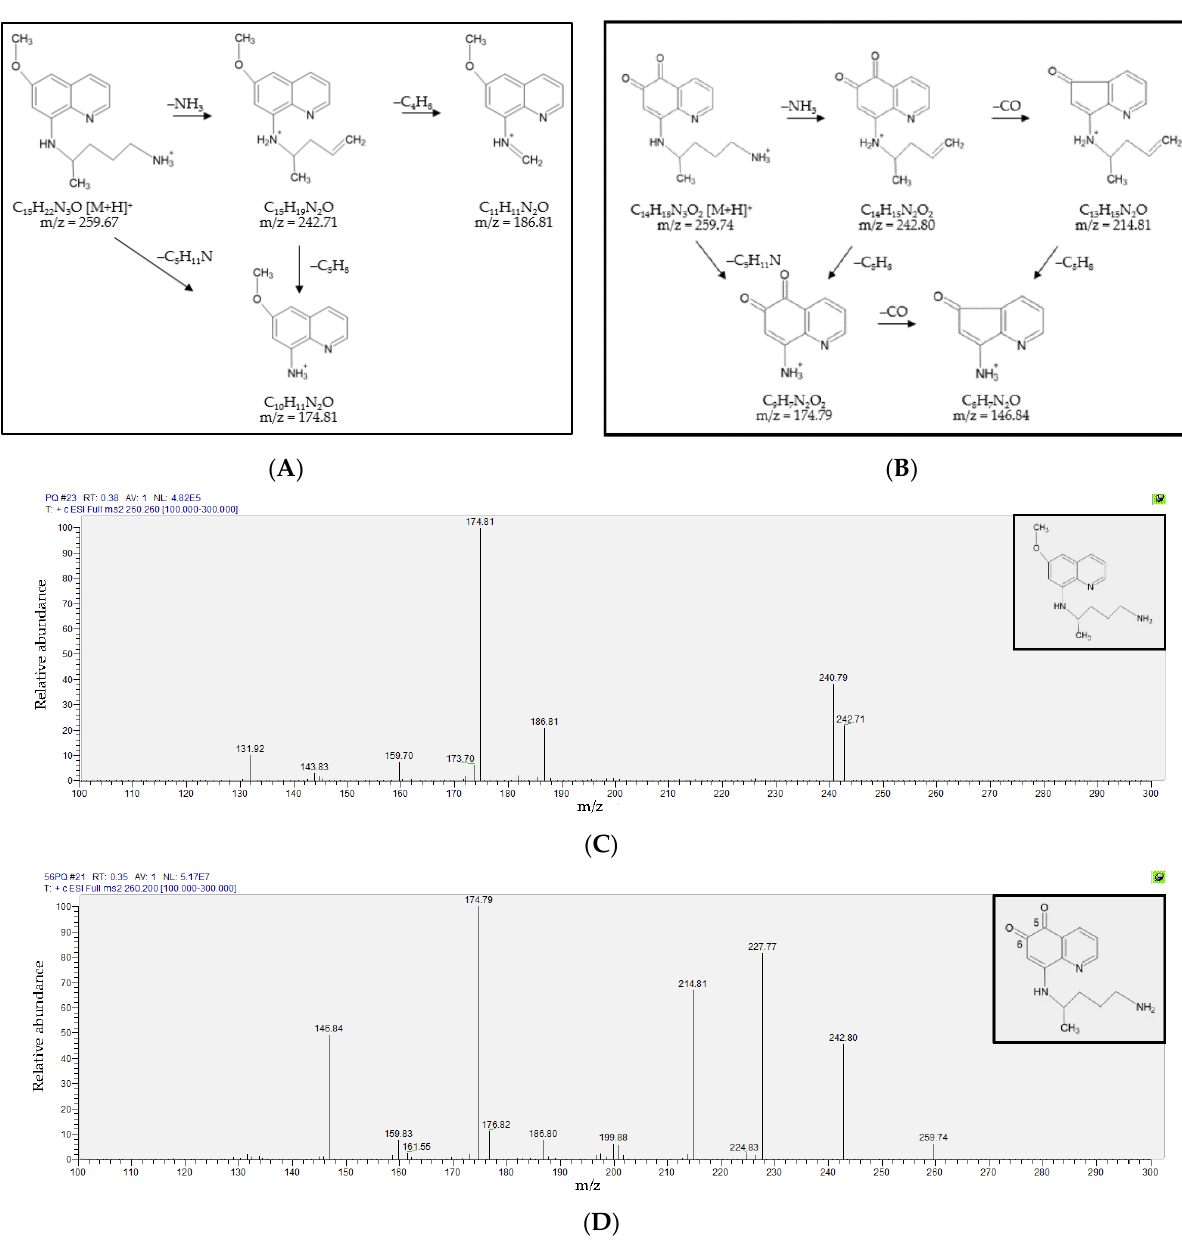
Figure 1 . The fragmentation patterns and the MS/MS spectra of primaquine (PQ) and 5,6-orthoquinone primaquine (5,6-PQ). The fragmentation patterns of ( A ) PQ; and ( B ) 5,6-PQ. The MS/MS spectra of ( C ) PQ showed the key fragments at m / z 242.71 (−17; – NH 3 ), 186.81 (−73; – C 4 H 11 N), and 174.81 (−85; – C 5 H 11 N); and ( D ) 5,6-PQ showed the key fragments at m / z 242.80 (−17; – NH 3 ), 214.81 (−45; – CH 3 ON), 174.79 (−85; – C 5 H 11 N), and 146.84 (−113; – C 6 H 11 NO).